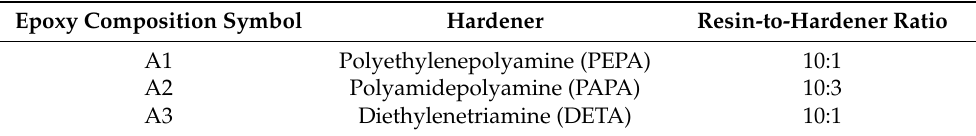
Table 1. The constitution of the epoxy